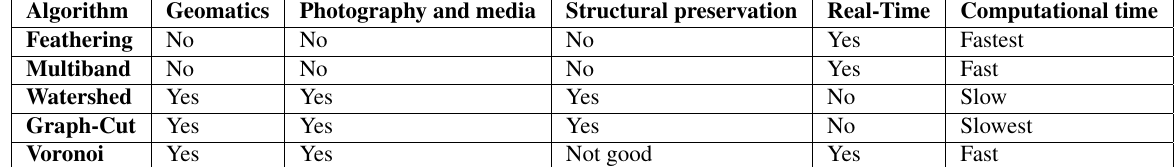
Table 2. Table of mosaicing use